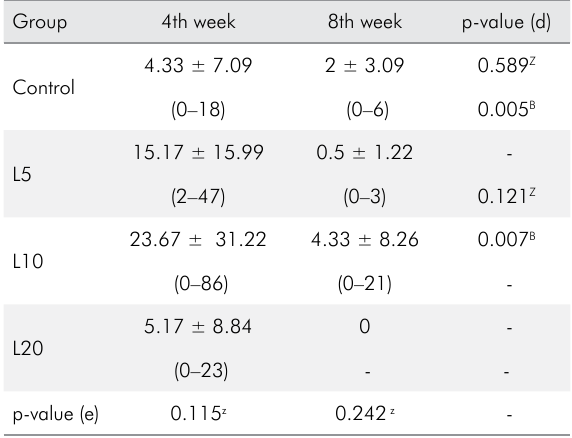
Table 5. Analysis of newly formed vessel number among groups and dependent on time; Data presented as mean ± standard deviation